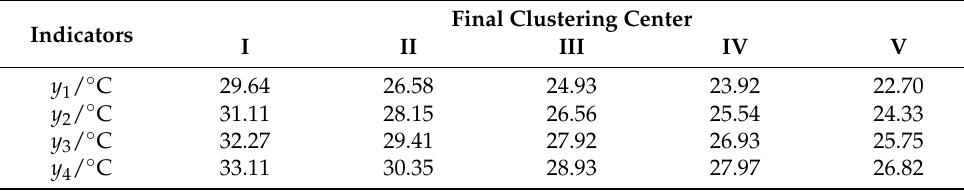
Table 3. Final clustering center temperature values.